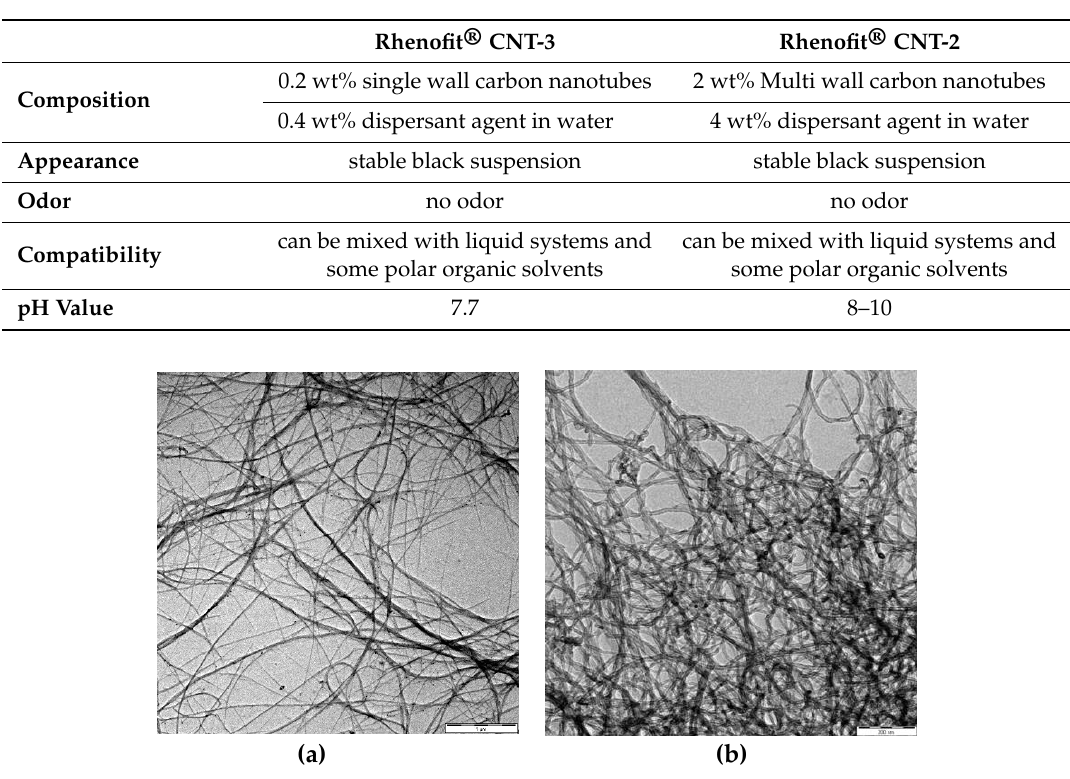
Figure 1. Transmission electron microscope images of: Rhenofit ® CNT-3 ( a ); and Rhenofit ® CNT-2 ( b ) from [60].